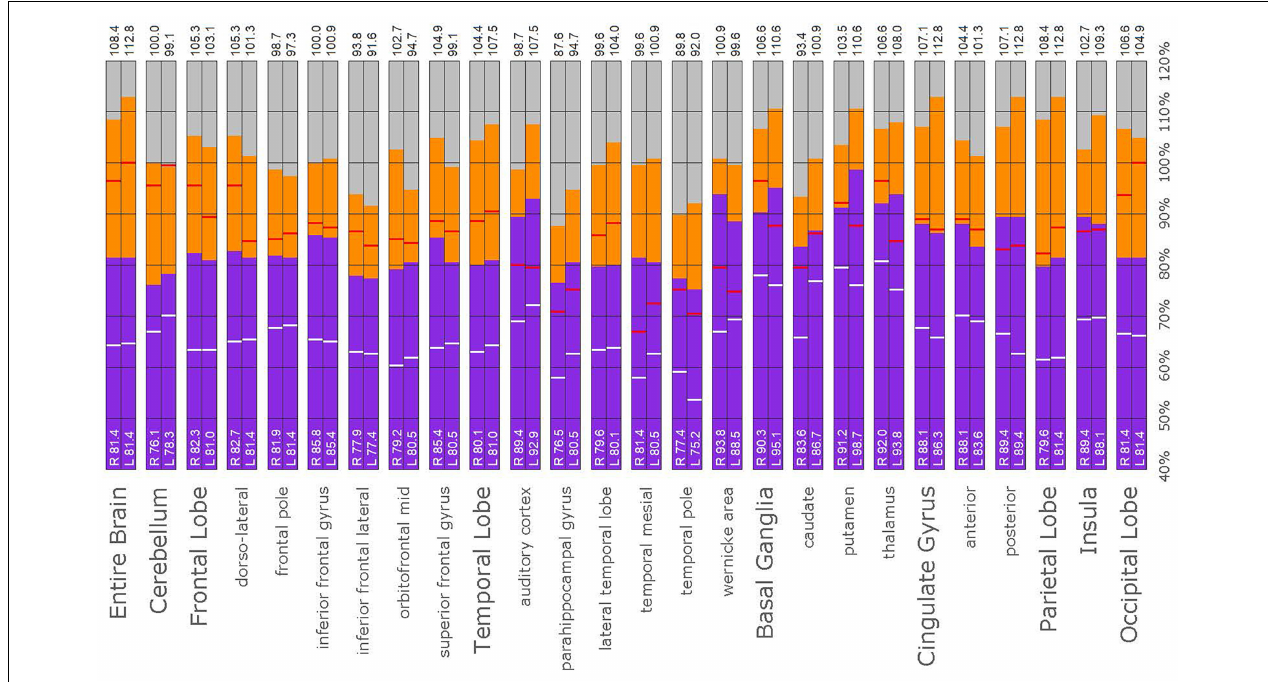
FIGURE 10 | Semi-quantitative region of interest analysis of the SPECT scan of Patient A in comparison to the normative sample. The scan data was normalized to the cerebellar maximal counts (cerebellar maximal for each patient equals 100% on bar graph). The median counts in each ROI is shown in purple and the maximal counts in each ROI is shown in orange. Right and left regions are illustrated as separate bar graphs with the median value printed in white lettering at the base of each bar. All 67 regions could not be illustrated in a single graph, so multiple ROI’s from the frontal, temporal, and cingulate cortices are illustrated, while the parietal, occipital, and insular cortices are each illustrated by a single bar. The median counts of the normative sample for that particular ROI are illustrated as a white line on each bar of the graph. The maximum counts of the normative sample for that particular ROI are illustrated as a red line on each bar of the graph. Markedly increased perfusion is evident in the thalamus (exceeding the maximal value in the cerebellum and the comparable maximal value of the normative sample). Markedly increased perfusion is seen in the frontal, temporal, parietal, insular, and cingulate cortices, again exceeding the maximal perfusion of the cerebellum and the comparable maximal value of the normative sample. In all ROI, with the exception of the cerebellum, the patient’s maximal counts exceed that of the normative sample (red line). In all ROIs, the patient’s median counts exceed that of the normative sample (white line). The asymmetry evident in the thalamus upon inspection of the scan is less obvious with ROI analysis. Asymmetry is notable throughout the